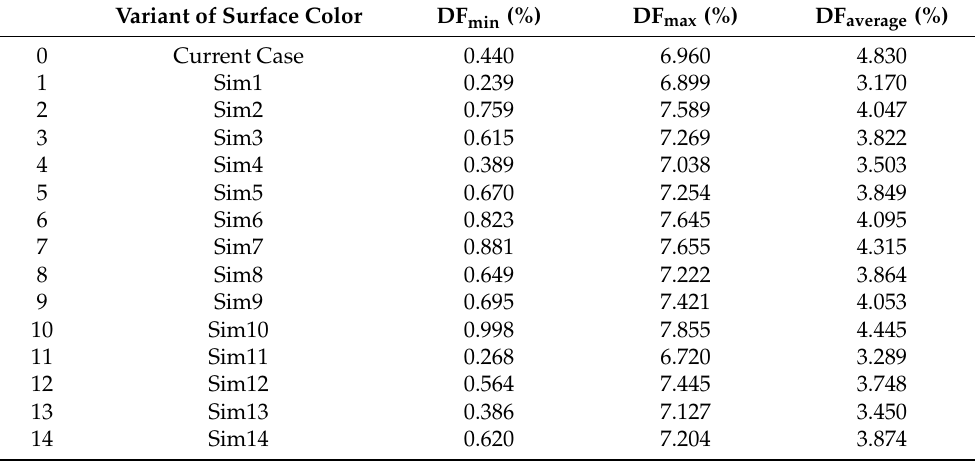
Table 4. Results of calculated DF by simulation program for variants of surface